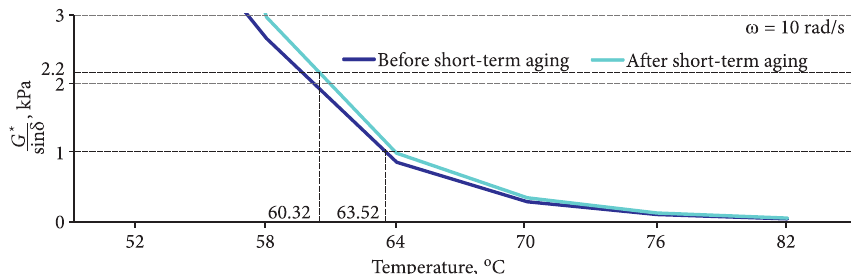
fig. 14. Determination of the resistance to rutting critical temperatures according to PG requirements for bitumen 50/70 produced by the producer